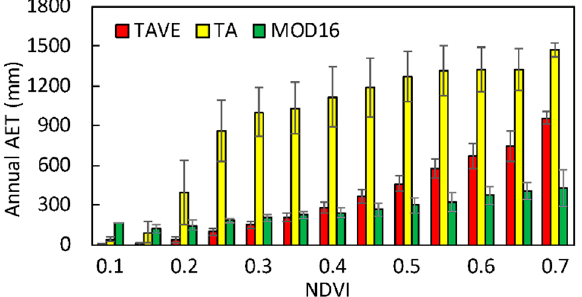
Figure 13. Comparison of annual AET estimates over different NDVI intervals across the study area. The bar shows the average value and the error bar shows standard deviation. The size of NDVI intervals is 0.5.